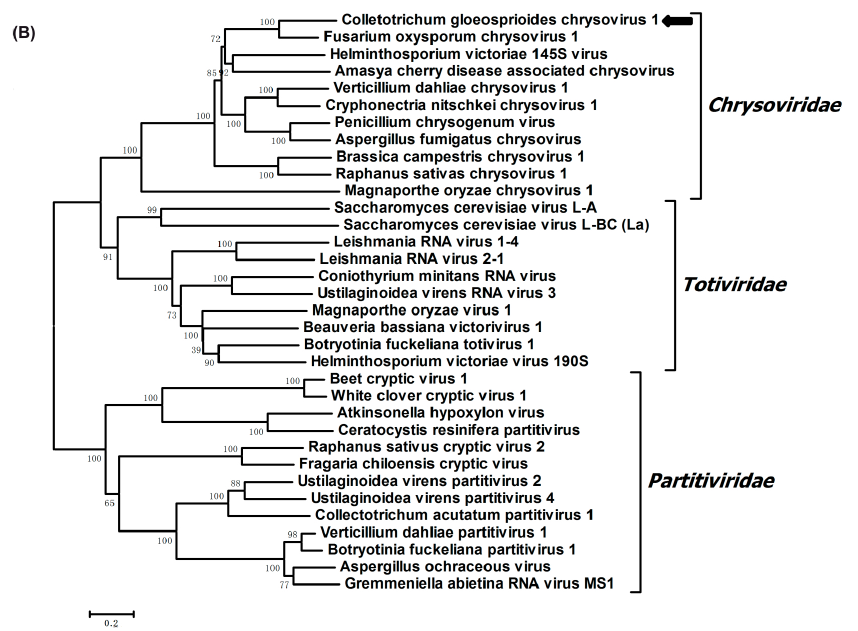
Figure 2. Alignment of amino acid sequences of viral RNA-dependent RNA polymerase (RdRp), and phylogenetic analysis of virus CgCV1. ( A ) Multiple alignments of putative RdRps of CgCV1 and other chrysoviruses sharing significant sequence similarities with CgCV1. The alignment was performed by CLUSTAL X and highlighted with the GeneDoc application. The conserved motifs of RdRp in dsRNA viruses are indicated by Roman numerals; ( B ) Phylogenetic analysis of the viral RdRp amino acid sequences of CgCV1. The phylogenic tree was constructed using the neighbor-joining method (1000 bootstrap replicates) in MEGA 6. Members in the families of Totiviridae , Partitiviridae , and Chrysoviridae were selected to conduct the multiple amino acid sequences alignment and phylogenic tree construction. These virus names and GenBank accession numbers are listed as follows: Amasya cherry disease-associated chrysovirus (CAH03664.1),